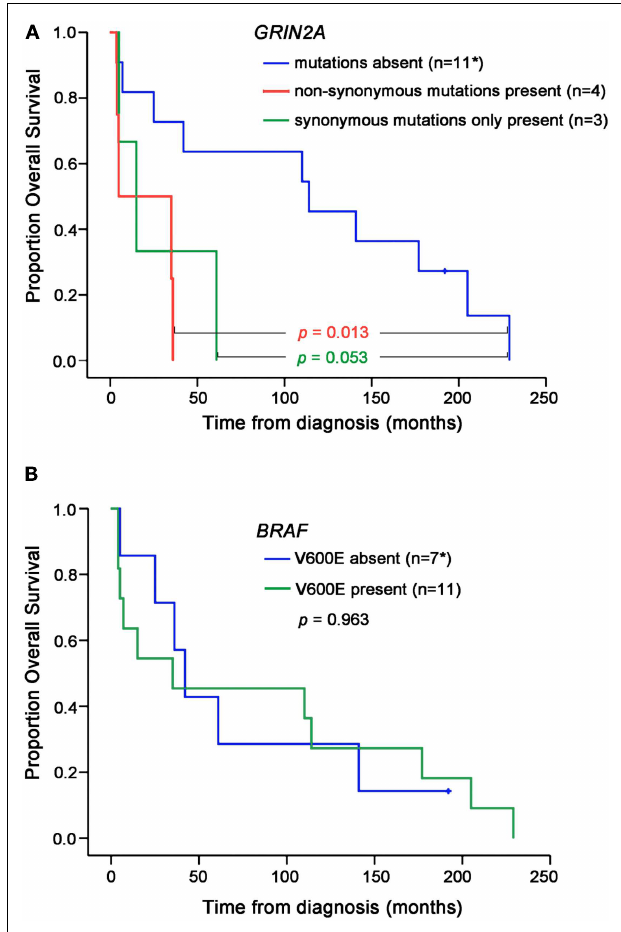
FIGURE 4 | Overall survival according to the GRIN2A (A) or BRAF V600E (B) mutation status . Levels of statistical significance are shown. *Data for one patient with non-mutated GRIN2A (V600E absent) was not